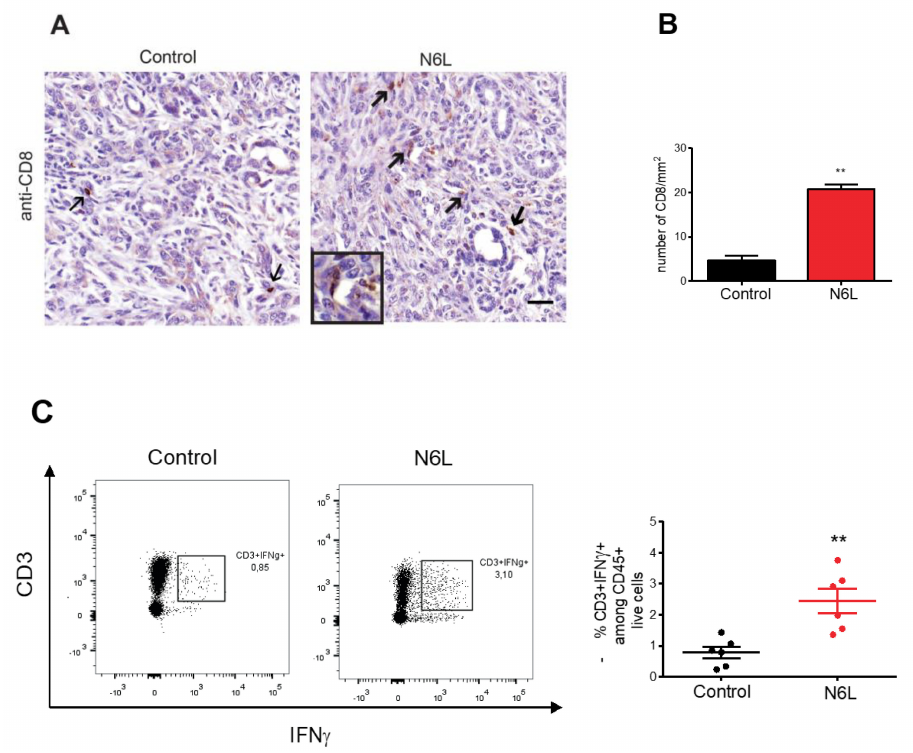
Figure 3. N6L increases lymphocyte infiltration and activation in mPDAC tumours. ( A ) Tumour sections of control and N6L-treated mice were immunostained by an anti-CD8 antibody to detect CD8 + cells (arrows); scale bar: 50 µ m. ( B ) CD8 + cells in tumoral regions (at least 4) of tumour slices were counted by using QuPath software, and the results were plotted as a mean for each tumour ( n = 6) as the number of cells/mm 2 . Two-tailed Mann-Whitney U-test (**, p < 0.01; n = 5 tumours) was applied. ( C ) Effector T cell activation was analysed by flow cytometry, and the % of CD3 + IFN γ + cells in control and N6L-treated mice is plotted (two-tailed Mann-Whitney U-test **, p < 0.01; n = 6